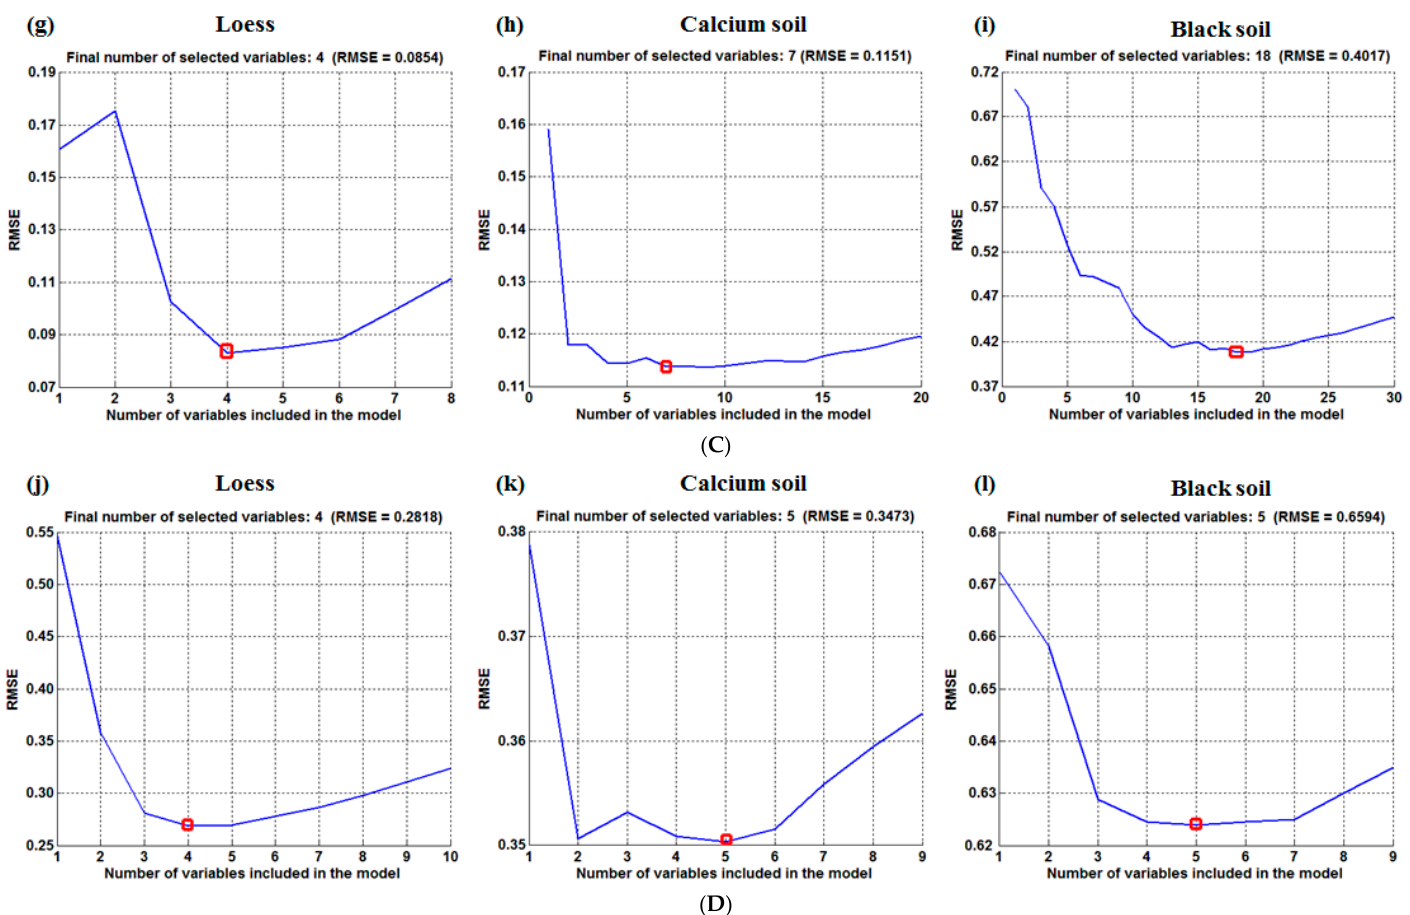
Figure 3. The wavelength number of loess, calcium and black soil selected by SPA: ( A ) 50 °C drying; ( B ) 80 °C drying; ( C ) 95 °C drying; ( D ) 25 °C placement. ( a , d , g,j ) are the loess wavelength number at 50 °C, 80 °C, 95 °C drying and 25 °C placement respectively; ( b , e , h , k ) are the calcium wavelength number at 50 °C, 80 °C, 95 °C drying and 25 °C placement respectively; ( c ),( f ),( j ) and ( l ) are the black soil wavelength number at 50 °C, 80 °C, 95 °C drying and 25 °C placement respectively.